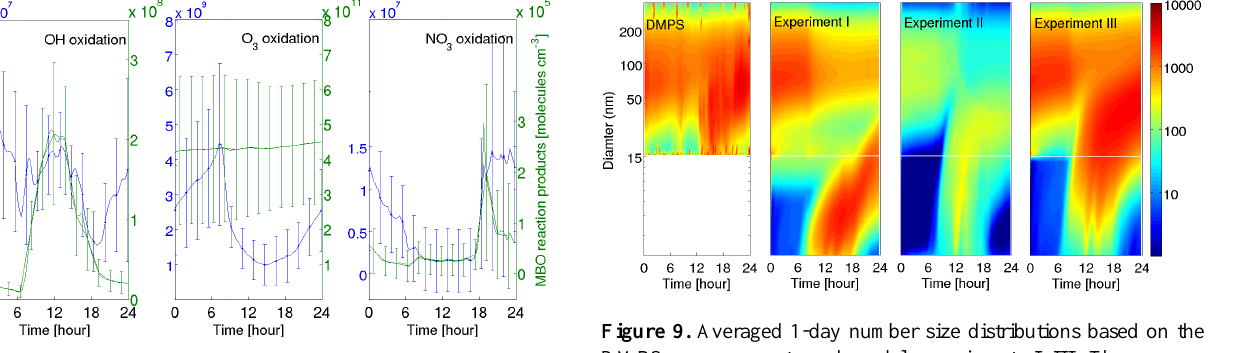
Figure 8. Averaged modeled diurnal cycles of OH, O 3 , and NO 3 oxidation products of monoterpenes (plotted against left y axis in blue) and MBO (plotted against right y axis in green). The error bars are ± 1 standard deviation.